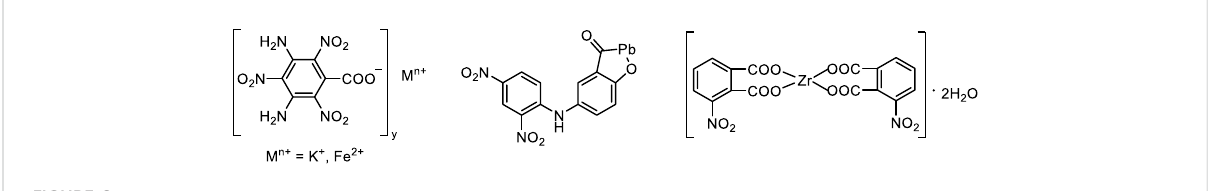
FIGURE 6 Metalsalt of4-(2,4,6-trinitrophenylamine)benzic acid,zirconium3-nitrophthalate and5-(2,4-nitrophenylamino)-lead salicylate (Kulkarni etal., 2005; Song et al., 2007; Zhang et al., 2009).